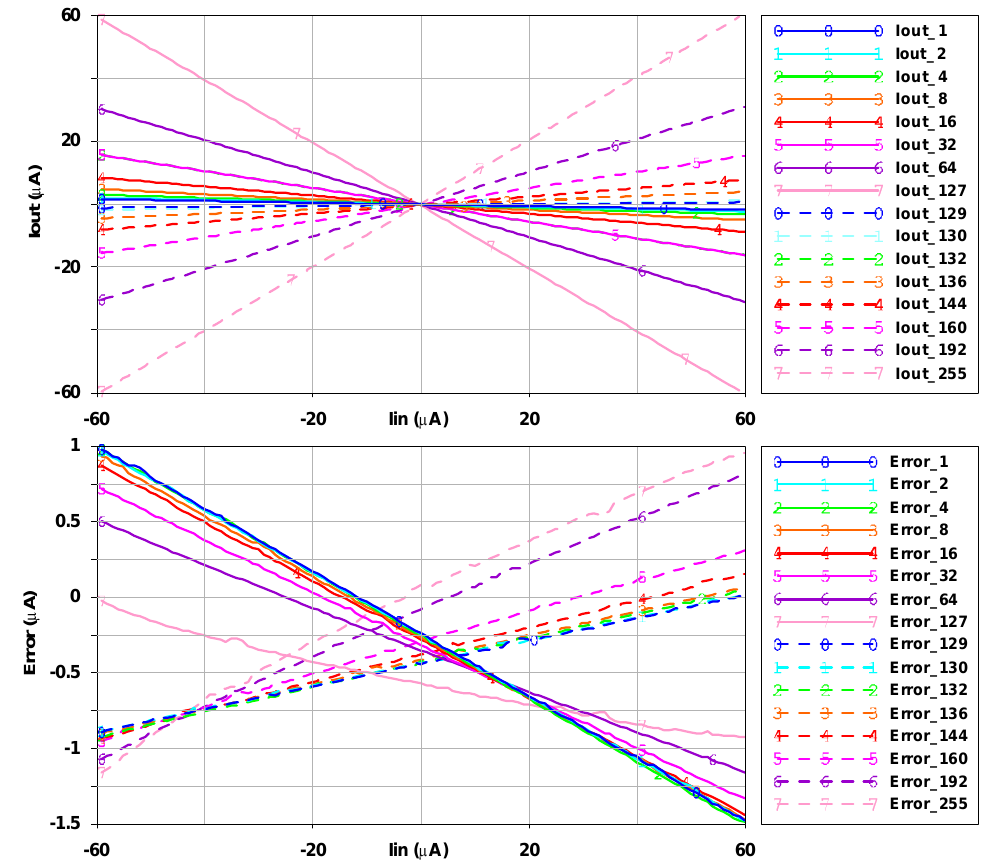
Figure 7 . (Top) Current ladder output. (Bottom) Output error (compared to the expected output).